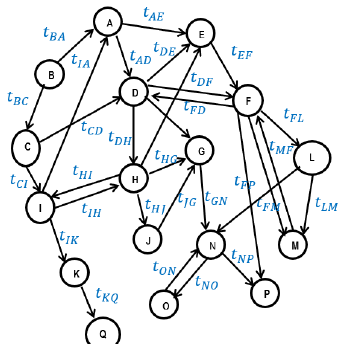
Fig. 2. Illustration of time network between